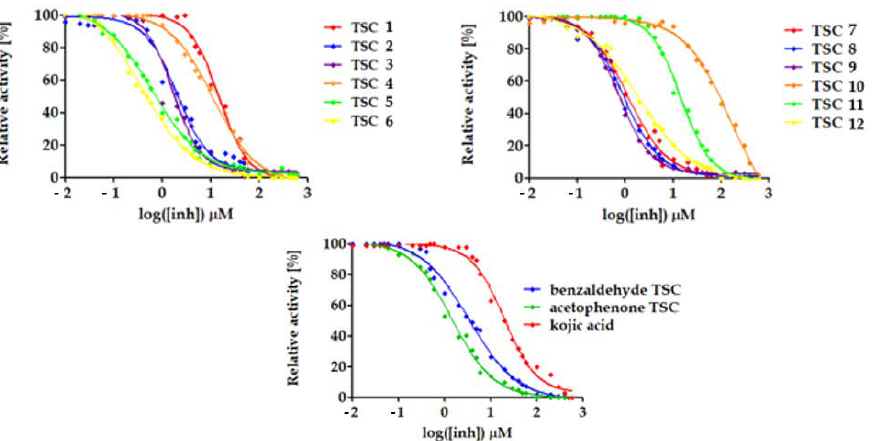
Figure 3. Dose–response curves for determination of half maximal inhibitory concentration (IC 50 ) for TSCs 1–12 and control compounds (benzaldehyde TSC, acetophenone TSC, and kojic acid) toward mushroom tyrosinase. The concentration of L -3,4-dihydroxyphenylalanine ( L -DOPA) was 1 mM in all the cases. Inhibitor concentration was in the range of 0.01 to 600 µ M.